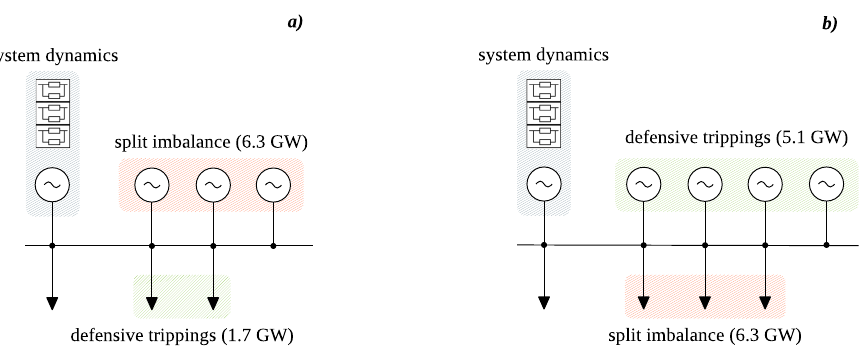
Figure 9. Outline of simulation systems: ( a ) North-West part. ( b ) South-East